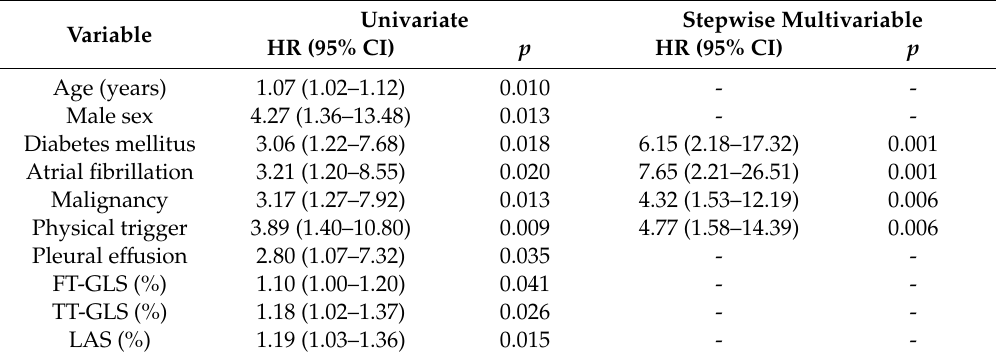
Table 3. Predictors of long-term mortality in univariate and stepwise multivariable Cox regression analysis.